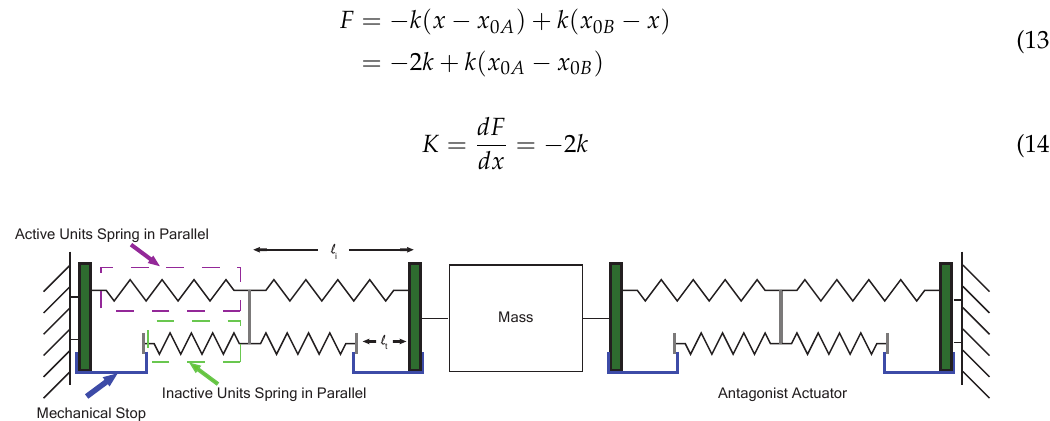
Figure 13. Antagonistic actuator